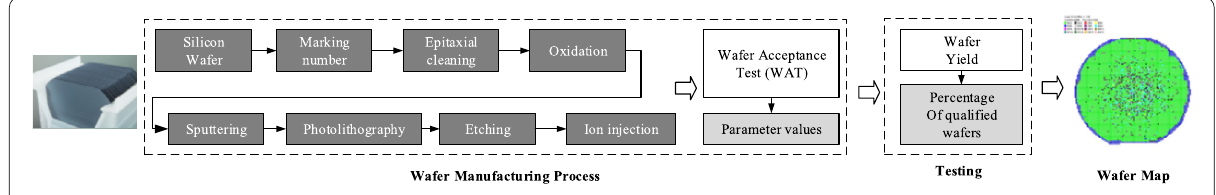
Figure 1 Wafer production and testing process (the final result is the wafer map after the test. The green point represents good and the other color point represents different types of